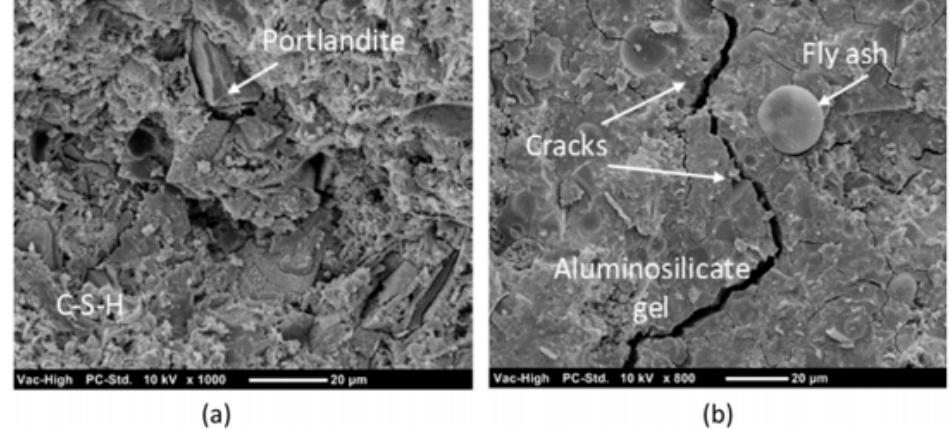
Figure 20. SEM image of ( a ) OPC paste and ( b ) alkali activated binder paste [149].